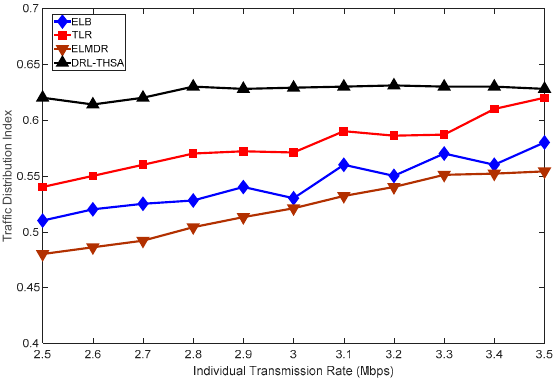
Figure 10. The traffic distribution index with different sending rates.